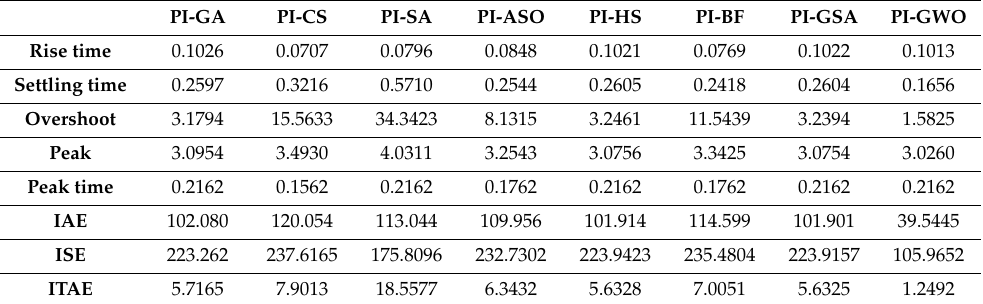
Table 6. Performance comparison of DC motor position control. IAE: integral absolute error; ISE: integral square error; ITAE: integral time absolute